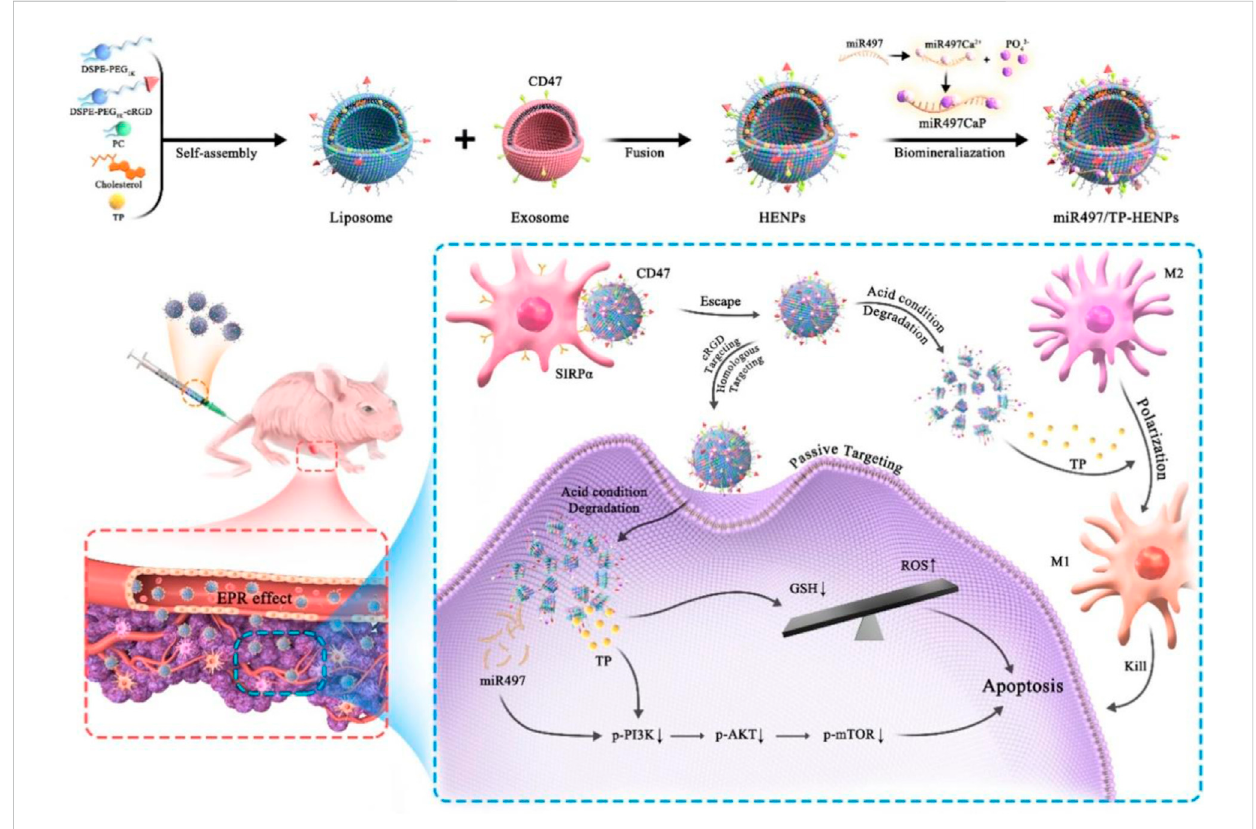
FIGURE 5 Diagram illustrating the formation process and miR497/TP-HENPs ’ mechanism of action (Li et al.,